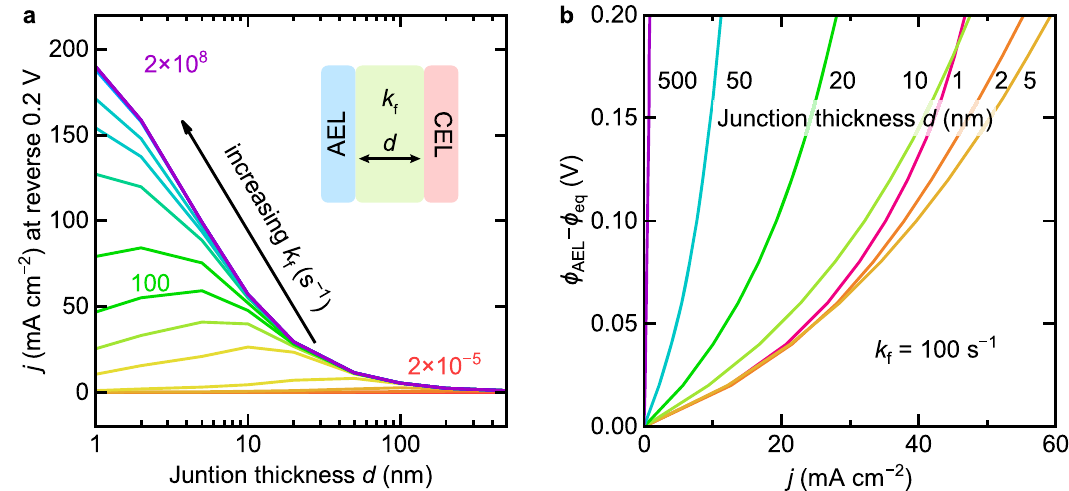
Fig. 4 Steady-state numerical simulated results of BPMs with different junction thickness and WD rate constant. a Current density at reverse bias of 0.2 V as a function of junction thickness for different WD rate constants in the junction. b Polarization curves in reverse bias for different junction thickness with WD rate constant k f = 100 s − 1 . Similar results using the reported diffusion coef fi cients for H + an OH − along with the fi xed ion concentration in the membranes estimated based on the manufacturer speci fi cations are in Supplementary Fig. 4. See Methods for more industry-standard Neosepta BPM (~1.2 V in H-cell at 100 mA cm − 2 (cid:3) 1 : 2V (cid:1) 0 : 83V ¼ 0 : 37V) 33 , we tested the BPM and 30 °C, η wd electrolyzer with optimal TiO 2 -P25 loading (~18 μ g cm − 2 ) at 30 °C (Supplementary Fig. 7 and Supplementary Discussion). EIS analysis